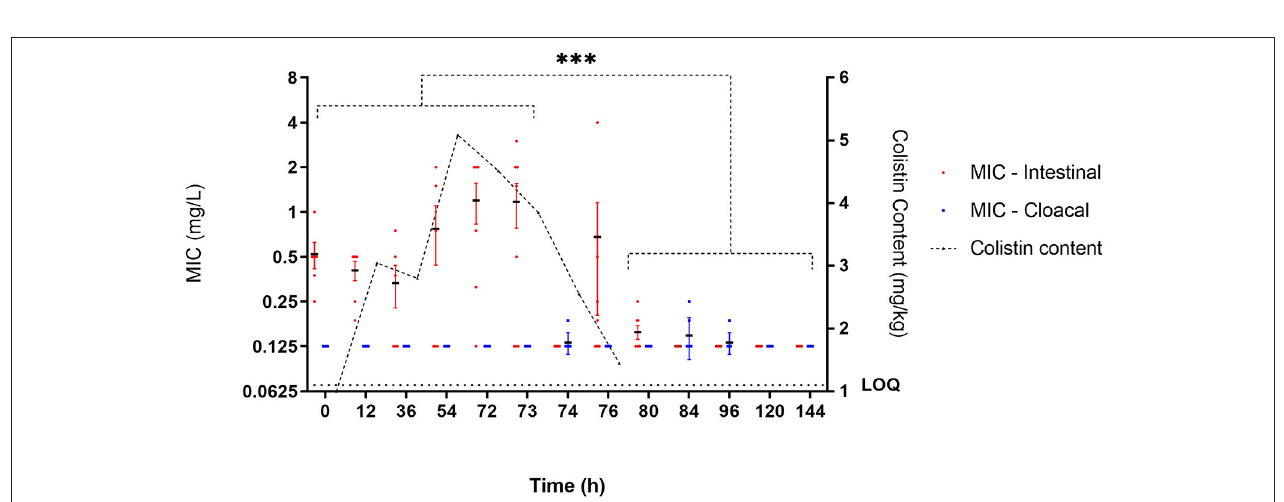
FIGURE 3 | E. coli susceptibility as measured by MIC (mg/l) during administration of colistin sulfate at clinical dose (75,000 IU/kg). Each individual point represents the mean MIC of isolates ( n = 8) for an individual bird. Black horizontal bar represents mean of all birds at that time point ( n = 6 or 8). Red and blue error bars represent SEM for intestinal and cloacal samples, respectively. Significance represents intestinal isolates only, and cloacal isolates are not considered representative of digestive bacterial population. ***Significant at p < 0.001.